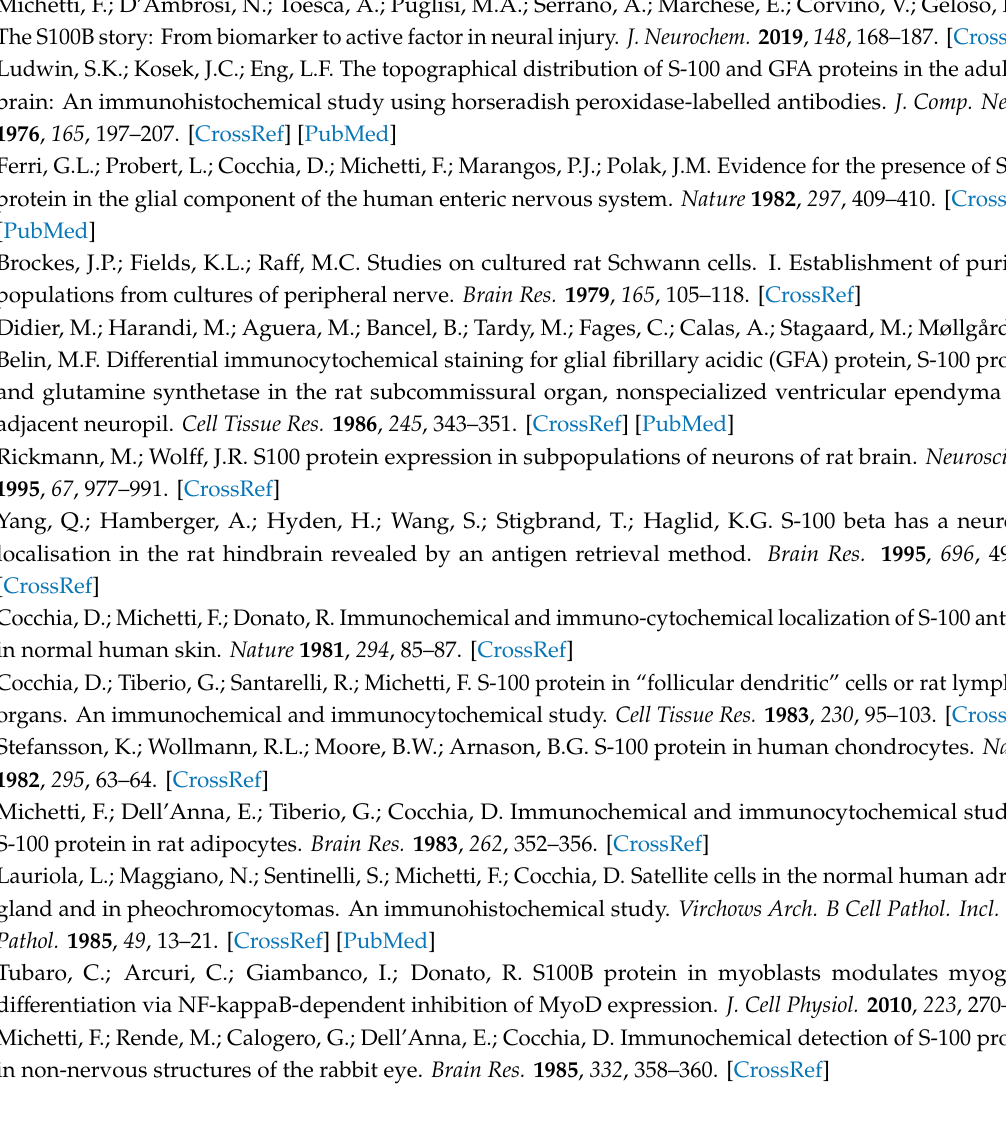
Figure S1: Beta diversity of the dataset microbiomes, Table S1: Dataset, Table S2: Reads count, Table S3: Microbiome composition at the phylum level, Table S4: Genus occurrence in microbiome samples categories, Supplementary